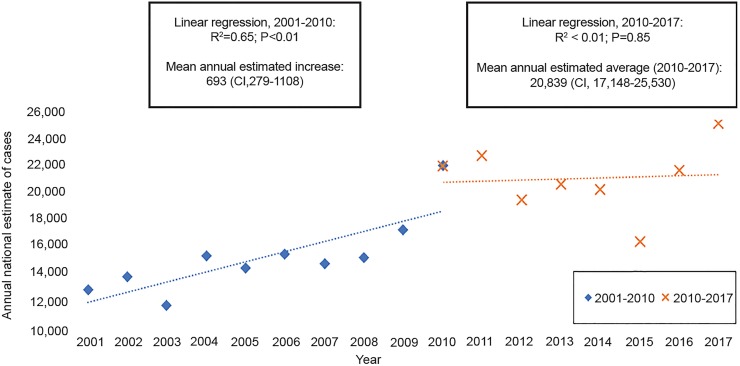
Weighted national estimates of pediatric patients presenting to U.S. emergency departments (EDs) with subluxations of the radial head, 2001–2017.CI; confidence interval.This figure overlays two linear regression models for the annual national estimate of radial head subluxations presenting to U.S. EDs between 2001 and 2017. The first linear regression model (blue, dotted line) uses annual national estimates (blue, filled diamonds) from 2001 to 2010 as inputs. The second linear regression model (orange, dotted line) uses annual national estimates (orange cross marks) from 2010 to 2017 as inputs. Results from the linear regression models are shown in the text boxes directly above each model.